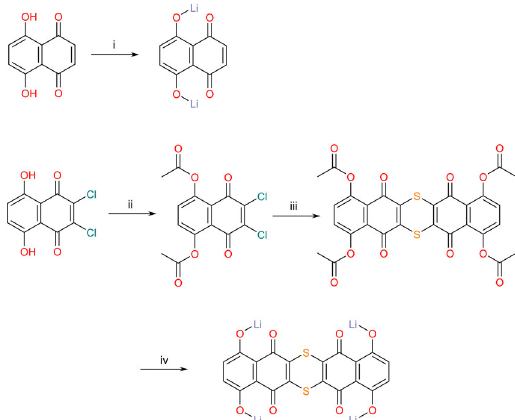
Fig. 2 Synthetic route for the lithium salts of the naphthazarin monomer 1 and the dimer 2. Reagents and conditions: (i) LiOH aq ., 50 °C; (ii) acetic anhydride, re fl ux; (iii) rubeanic acid, TEA/DMF, 50 °C; (iv) LiOH, H 2 O/ THF, 70